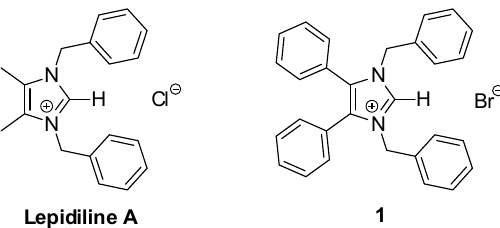
Figure 1. Natural product Lepidiline A and 1,3-dibenzyl-4,5-diphenylimidazolium bromide, 1 .